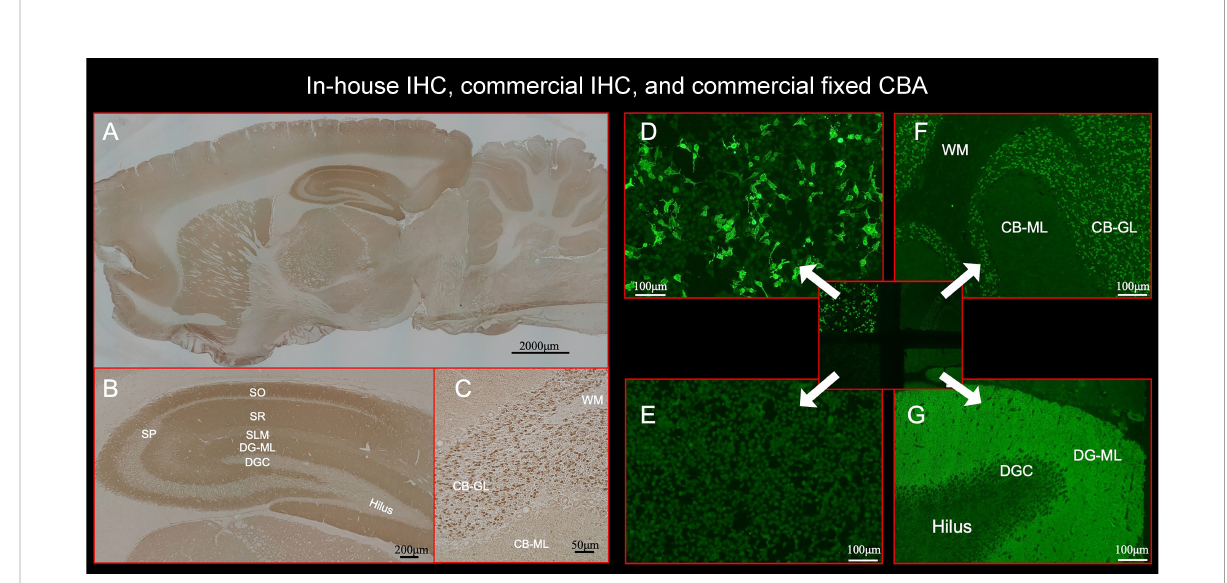
FIGURE 2 This fi gure shows the results of immunostaining pattern using in-house IHC (A – C) and commercial kit, which consists of 4 biochips per fi eld containing the NMDAR-transfected cells (D) , control-transfected cells (E) , cerebellum (F) , and hippocampus (G) . Note intense reactivity with NS antigen in the DG-ML (A, B, G) , less intense dot-like reactivity in the CB-GL but no apparent reactivity on the CB-ML (C, F) . This staining pattern is consistent with NMDAR. (D) shows intense staining on NMDAR-transfected cells but not on control-transfected cells (E) , con fi rming the diagnosis of anti-NMDAR encephalitis. Antibody assay was performed using CSF (diluted 1:2) obtained from a patient with anti-NMDAR encephalitis (antibody titer 1:2048), with in-house IHC adapted to NS antigens (A – C) , commercial fi xed CBA (D, E) , and commercial IHC (F, G) . See Text. CBA, cell-based assay; CB-GL, cerebellar granular layer; CB-ML, cerebellar molecular layer; DGC, dentate granule cells; DG-ML, dentate gyrus molecular layer; IHC, immunohistochemistry; NMDAR, NMDA receptor; NS, neuronal surface; SLM, stratum lacunosum moleculare; SO, stratum oriens; SP, stratum pyramidale; SR, stratum radiatum; WM, white